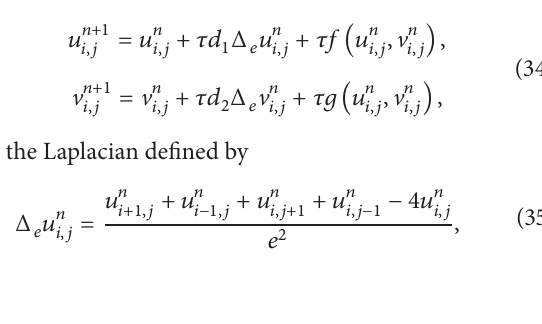
[35] with a time step size of 1/100 . The initial condition is always a small amplitude random perturbation around the positive constant steady-state solution 𝐸 ∗ = (𝑢 ∗ , V ∗ )